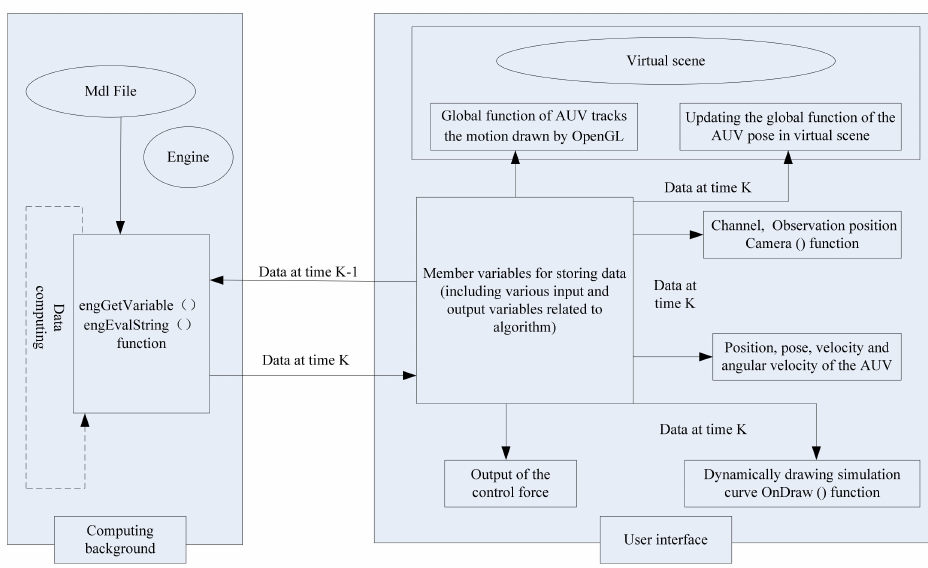
Figure 11. Data communication between the VR system and